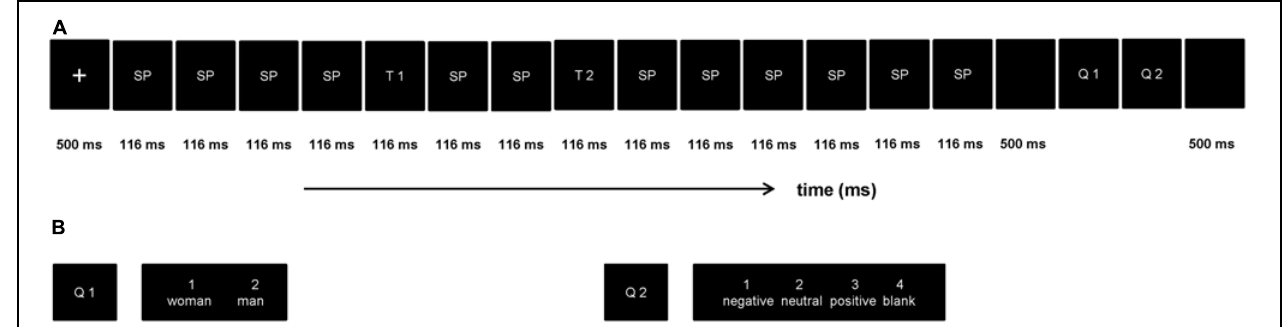
FIGURE 1 | The rapid serial visual presentation (RSVP) paradigm used in this experiment. (A) Each trial contained 10 scrambled pictures (SP), two target stimuli (T1 and T2), and two questions (Q1 and Q2). The T1 emerged randomly and equi-probably at the fifth, sixth, seventh position, T1 and T2 were presented within an interval of 232 ms. (B) Example for the two questions in each